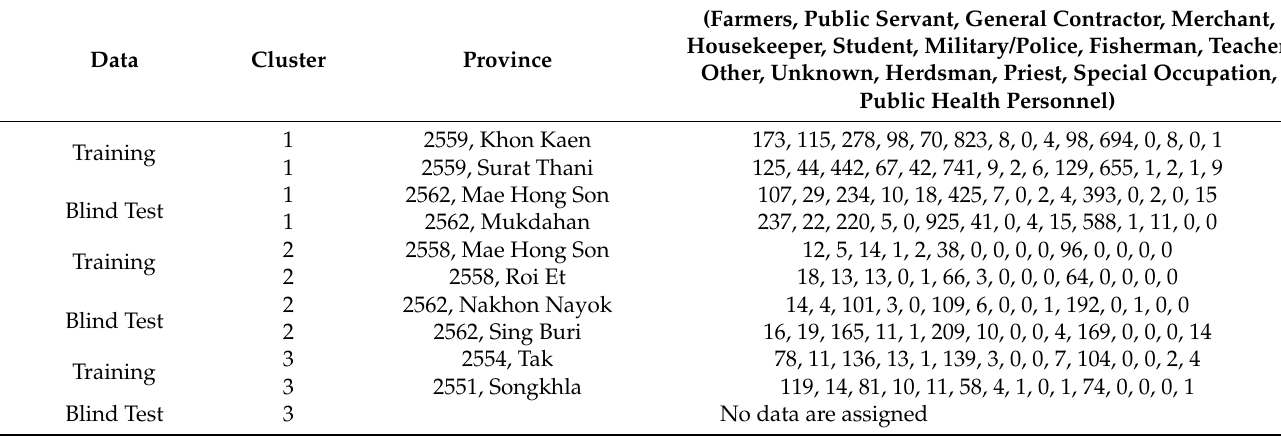
Table 13. The example of clustering results from the selected models for the influenza dataset for the career